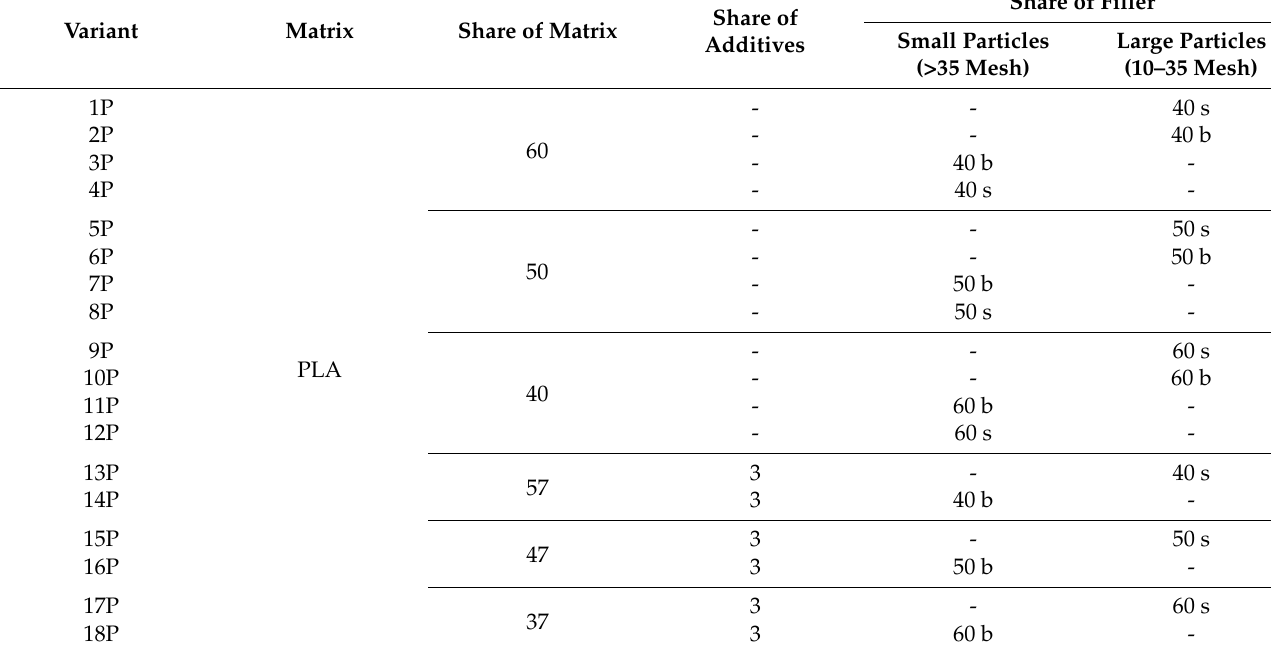
Table 2. HDPE-based composites characteristics.